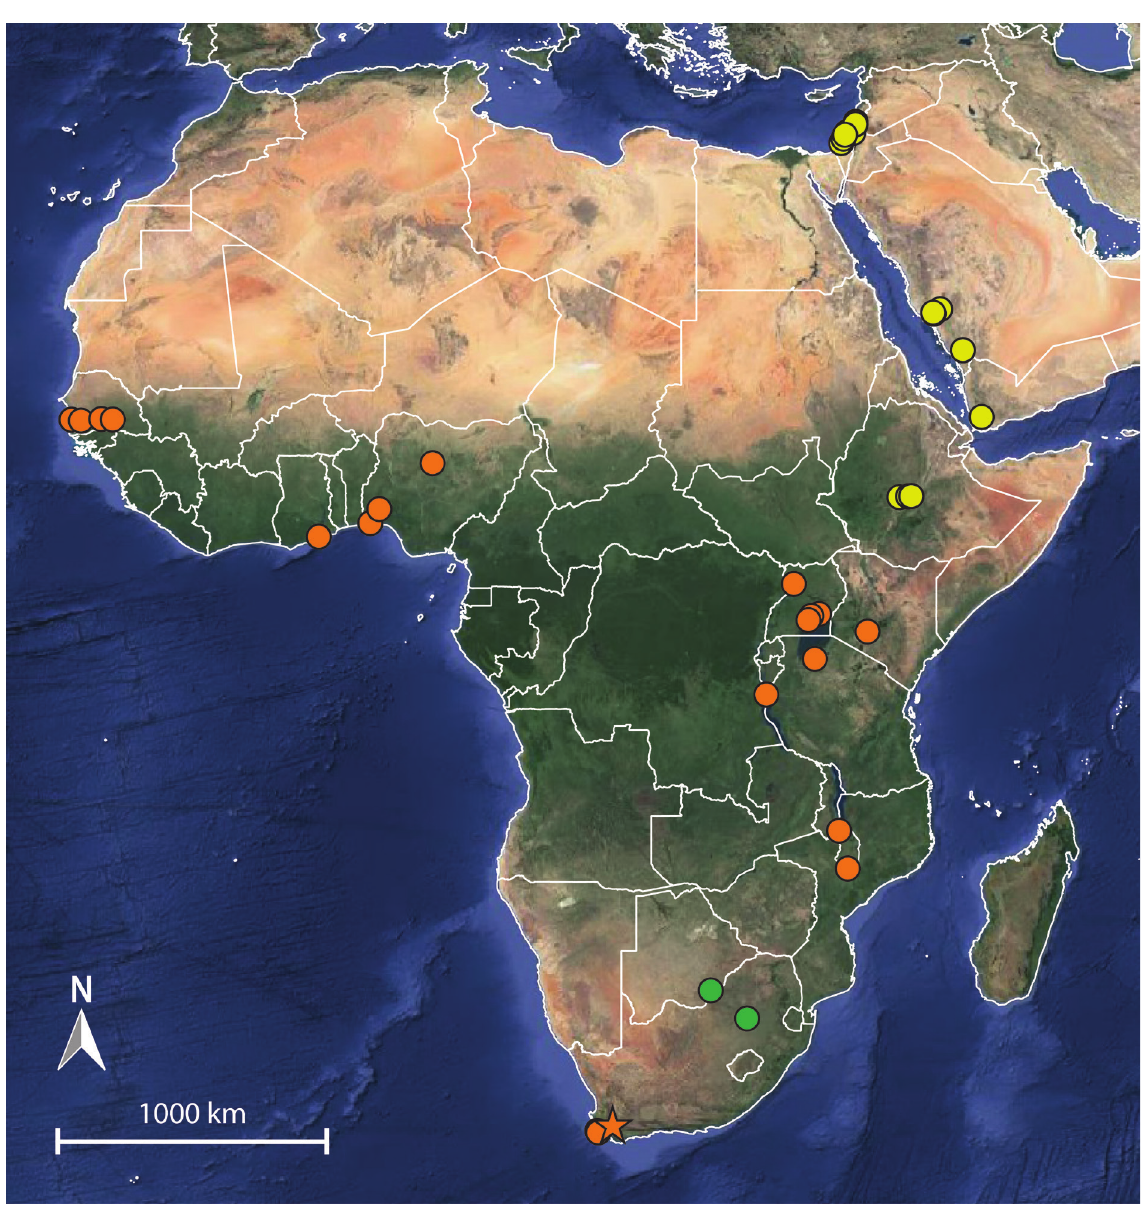
Fig. 2. Reported localities for Cloeon perkinsi . Approximated previously reported localities (orange; star indicates type locality), collecting sites for the present study (yellow), and photograph-based localities (green). Map originated from Google